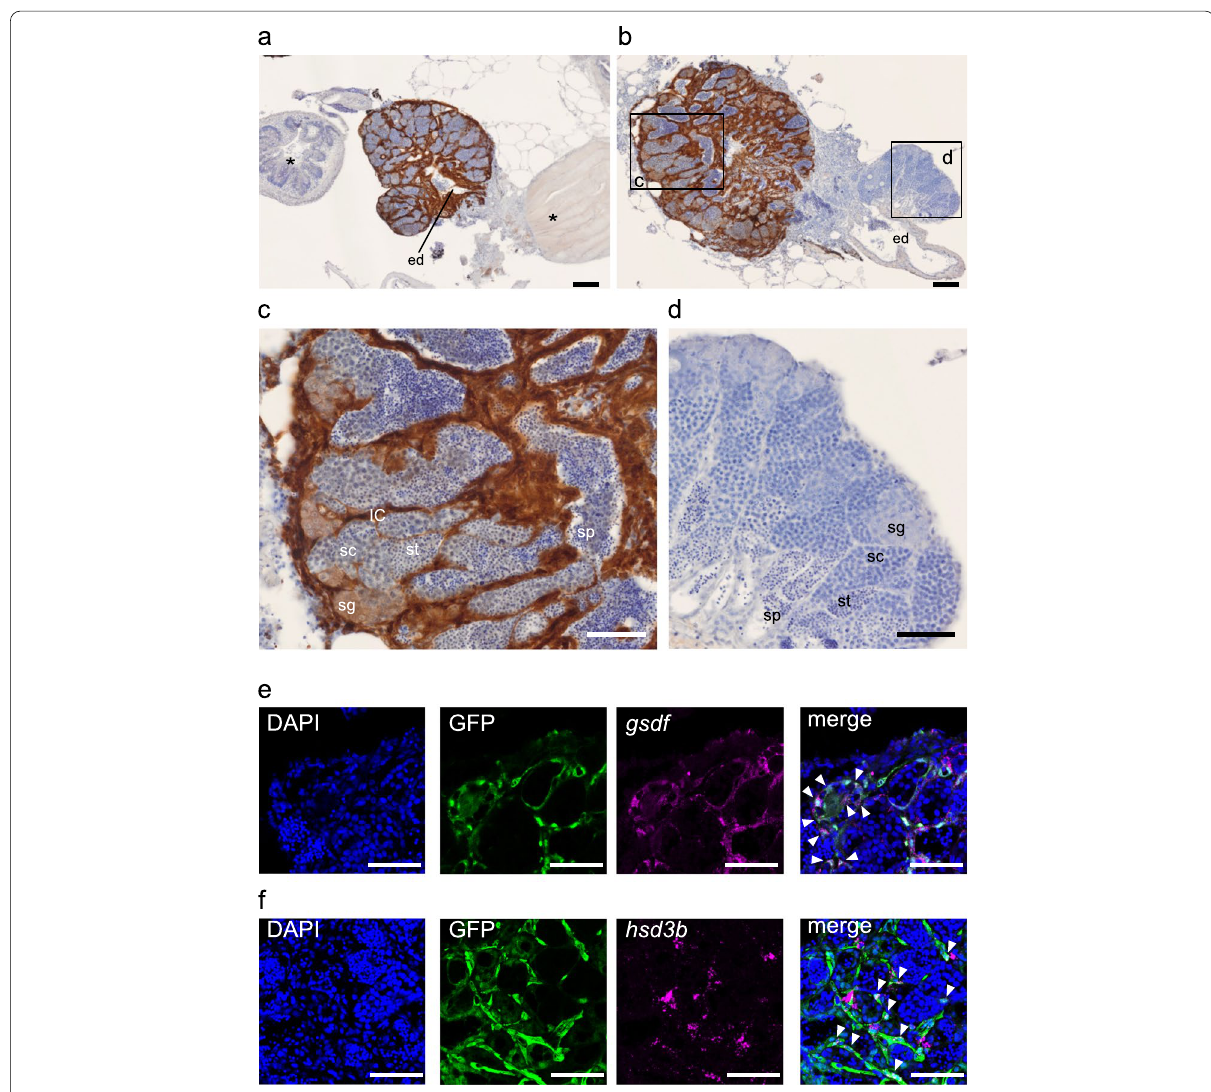
Fig. 4 Allografted testicular tissue, including somatic cells, was fused with the recipient testis. a–d Representative images of IHC analysis using an anti‑GFP antibody visualized by DAB. Sections were counterstained by hematoxylin. DAB‑positive cells are donor‑derived ( actb ‑GFP strain) cells. a Representative image from IHC analysis of the recipient whose testis was mainly derived from allografted (donor‑derived) testis. The actb ‑GFP strain was used as a donor male. ed, efferent duct. Asterisks denote non‑gonadal tissue of the recipient. Scale bar, 100 μm. b Representative image from IHC analysis of the recipient whose testis was partly derived from allografted testis. F1 hybrid of actb ‑GFP strain and recipient strain ( actb ‑GFP hetero) were used as a donor male. Scale bar, 100 μm. The boxed areas are magnified in panel c GFP‑positive area (donor‑derived tissue) and d GFP‑negative area (recipient‑derived tissue). IC, interstitial cells; sg, spermatogonia; sc, spermatocyte; st, spermatid; sp, spermatozoa. Scale bar, 50 μm. e, f Identification of the presence of Sertoli or Leydig cells in the allografted testis. The panels show the images of nuclear counterstaining (DAPI, blue), the cells of allografted testis (GFP, green), the expression of indicated marker genes ( e gsdf , f hsd3b ; magenta), and the merged image from the left in the same sections. Arrowheads denote representative cells that showed co‑existence of the GFP and indicated marker genes. Scale bar, 50